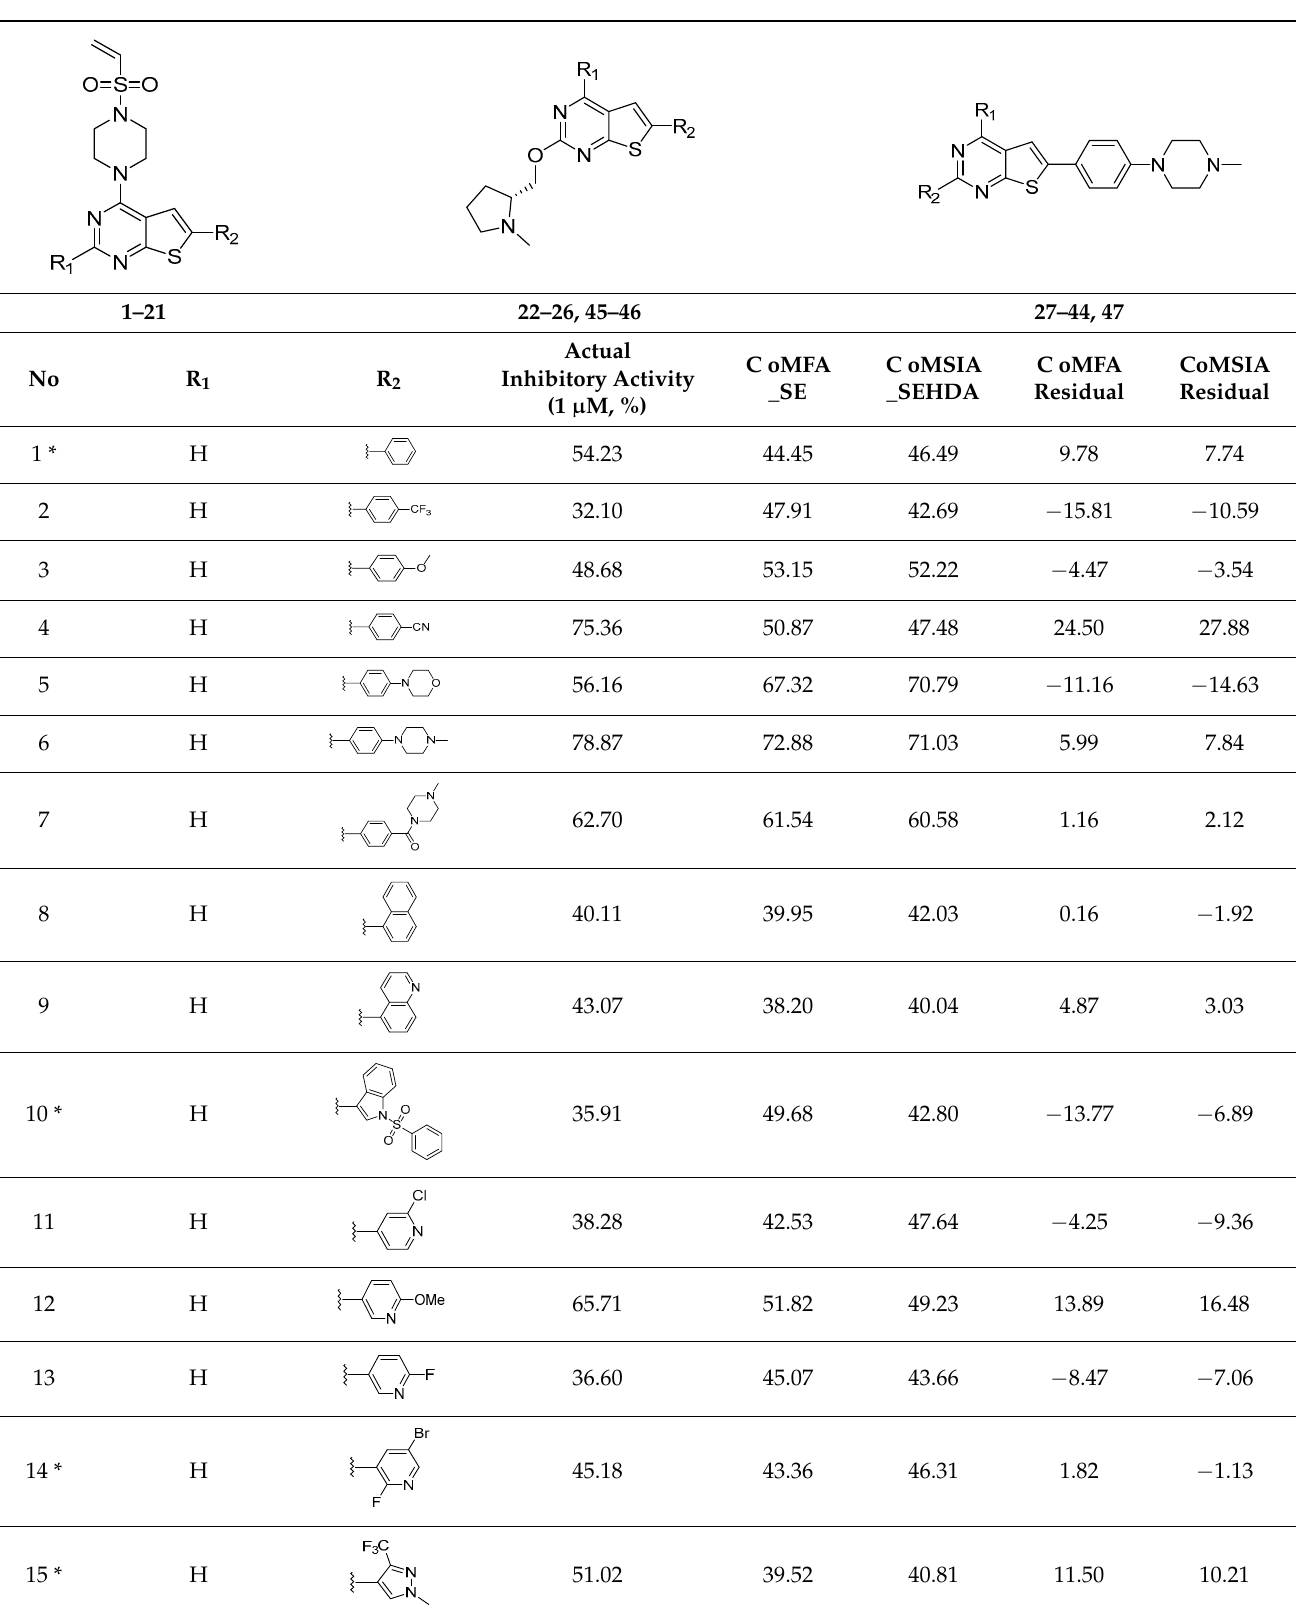
Table 6. Chemical structures and inhibitory activity values of thieno-pyrimidine derivatives.